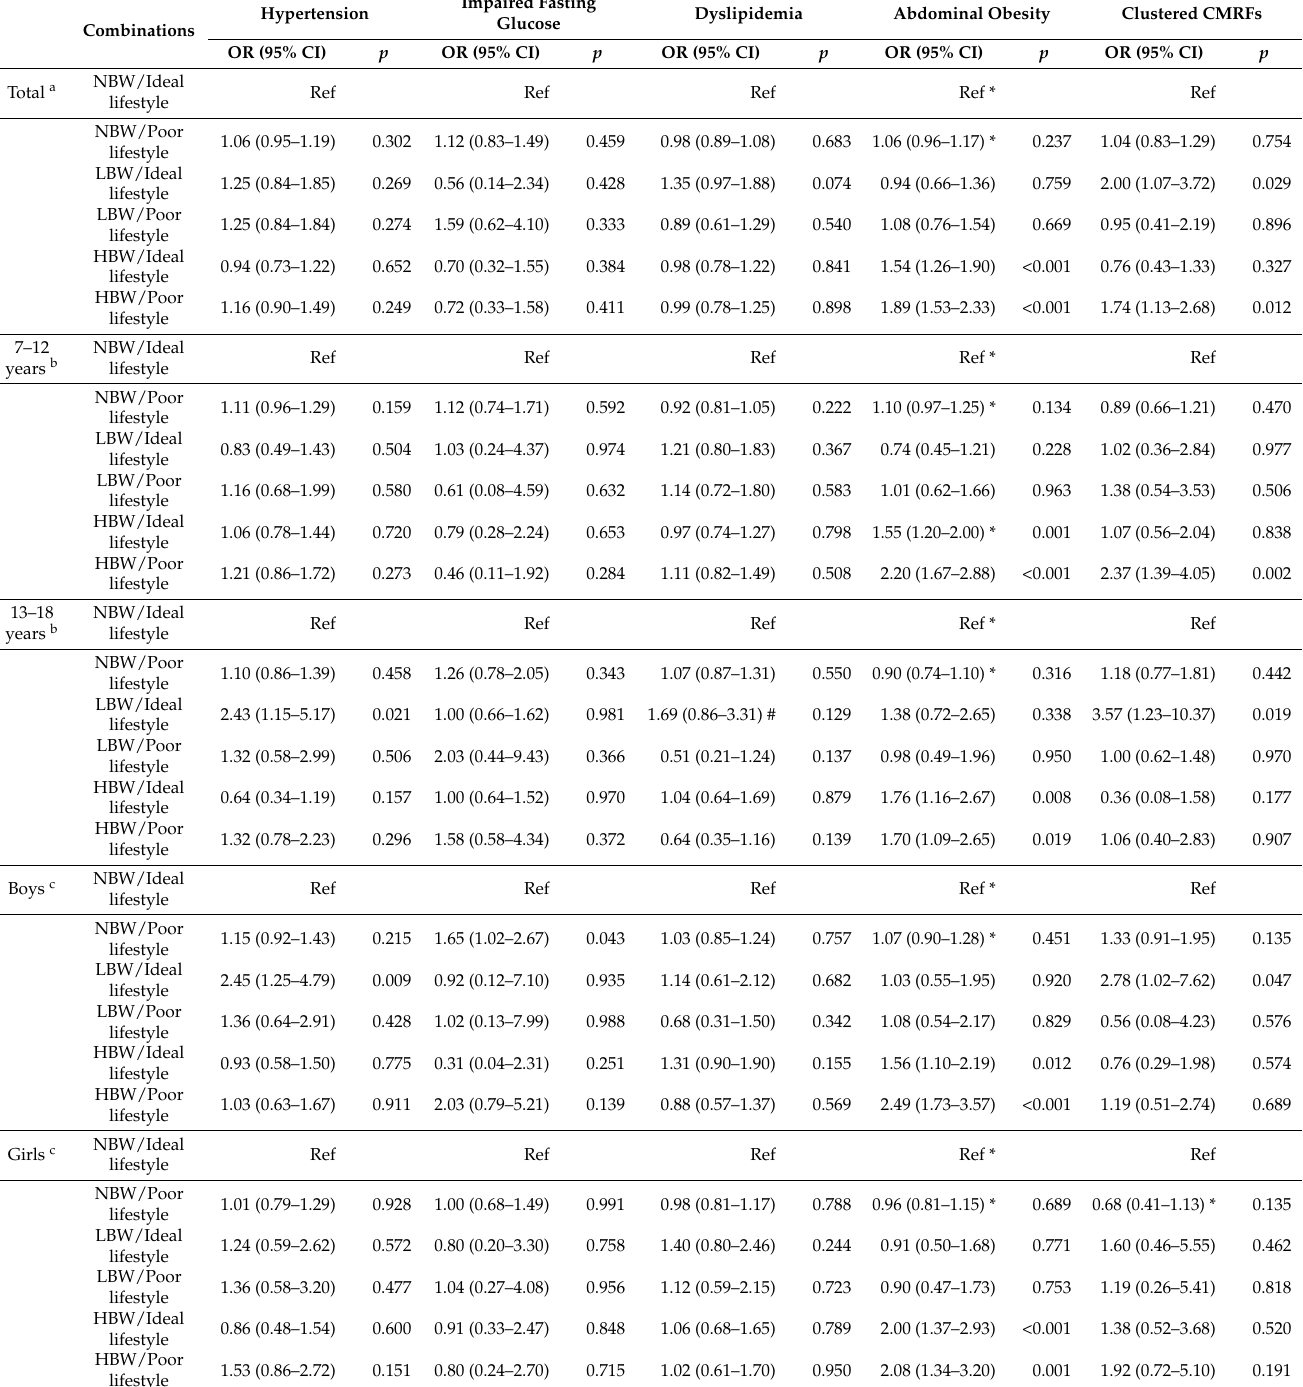
Table 5. Associations between CMRFs, clustered CMRFs and combinations of birth weight and lifestyle in mixed effect models stratified by age and sex